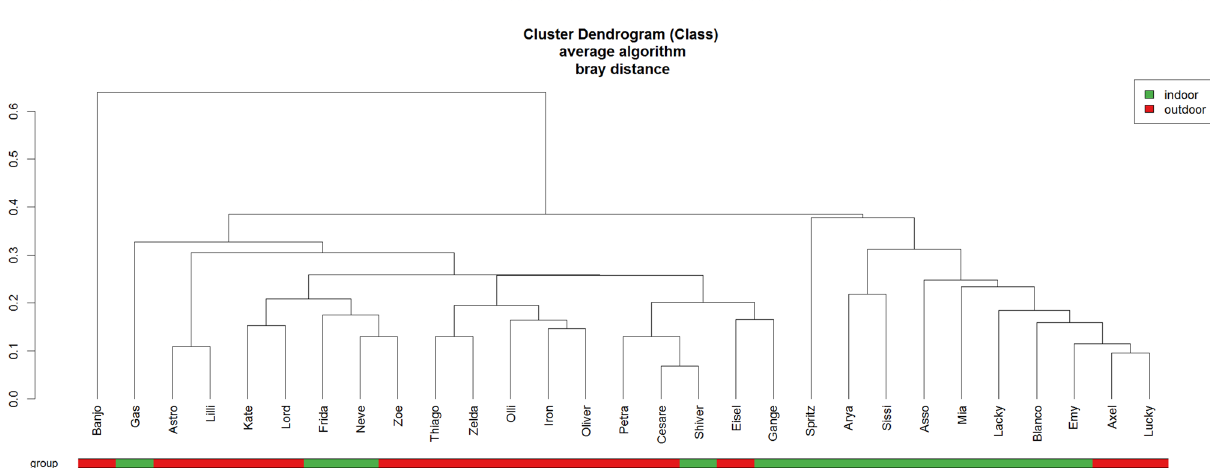
Figure 5. Cluster dendrogram of the average algorithm on Bray–Curtis distance between the recruited indoor (n = 13; green colour) and outdoor dogs (n = 16; red colour) at class level. Dogs’ names were used to distinguish the analysed samples. This figure was created using R version 3.4.3 (https:// www.r- proje ct.